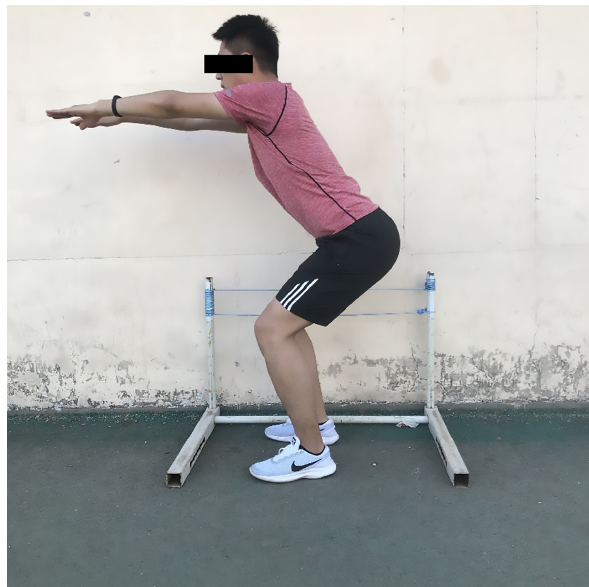
Fig. 7. Above the marking area.